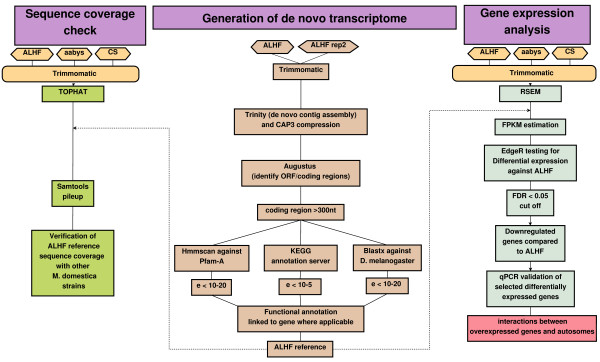
Data analysis pipeline for the generation of the Musca domestica predicted gene set and differential gene expression testing. Hexagons represent the raw data collected for this study, while terms within boxes represent either the programs, or the filtering steps used in the data analysis. The directions of the arrows indicate the data processing flow.